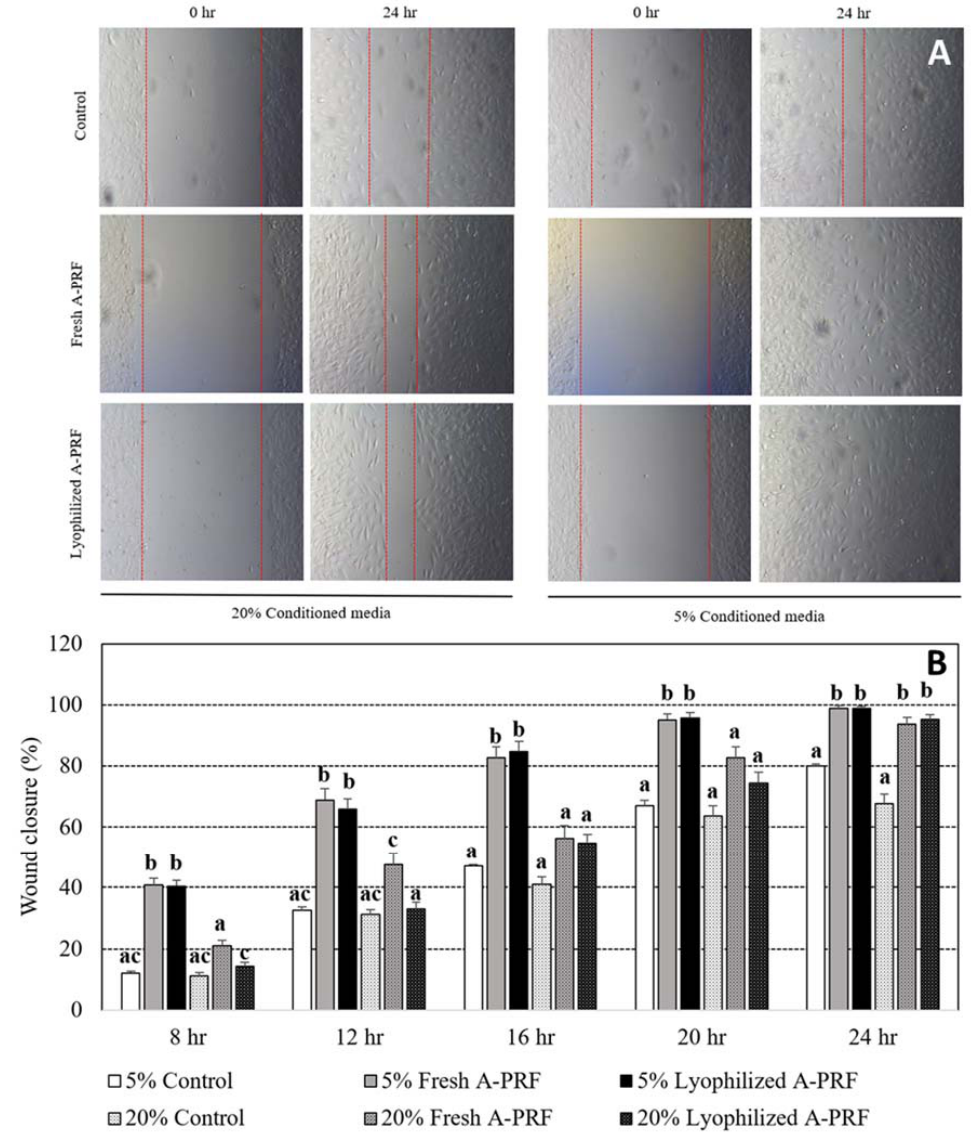
Figure 4. Examples of the representative time lapse images of the fibroblast wound healing assay at 0 and 24 hr for each group ( A ). Percentages of wound closure after culturing for 8, 12, 16, 20, and 24 hr in the standard cultured medium supplemented with 5% and 20% of the control media, the fresh A-PRF, and the lyophilized A-PRF ( B ). a,b,c : different letters indicating significant differences between the control, fresh A-PRF, and lyophilized A-PRF within the same specified